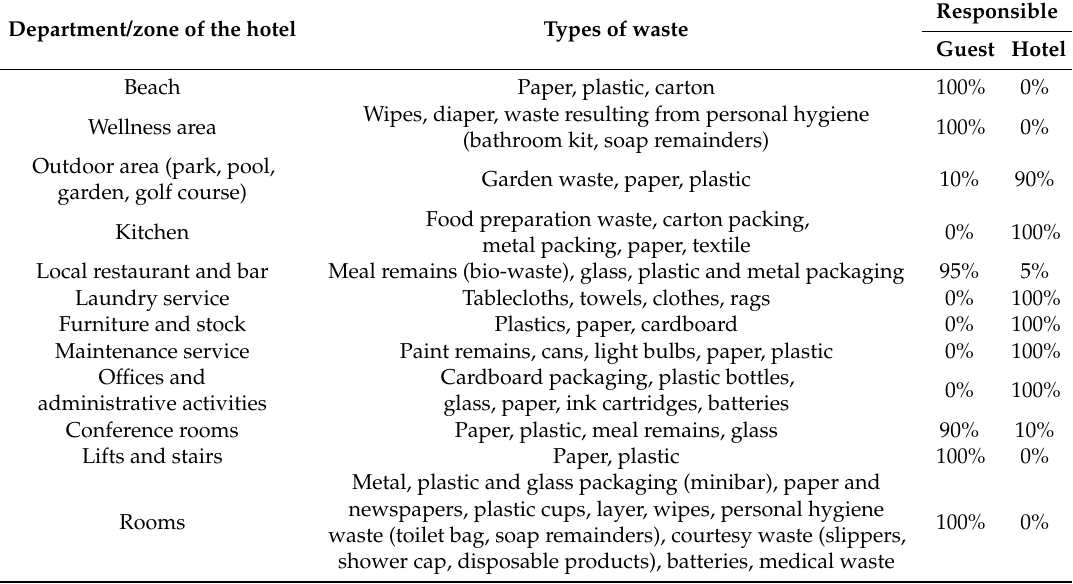
Table 2. Principal types of solid waste (SW) generated from different hotels departments.